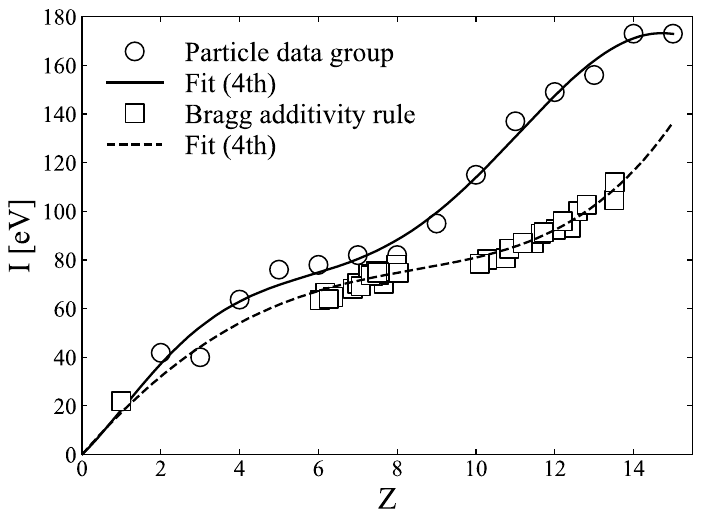
Figure 4. I -values of element obtained from the Particle Data Group (PDG) database, and I -values of a mixture of human tissue from Table 1 of Bourque et al. [4] calculated using Bragg additivity rule. Each solid line or dashed line is the result of fourth-order polynomial fitting, respectively. Table 1. Elemental compositions and mass densities of the biological phantom materials. Elemental Composition (Percentage by